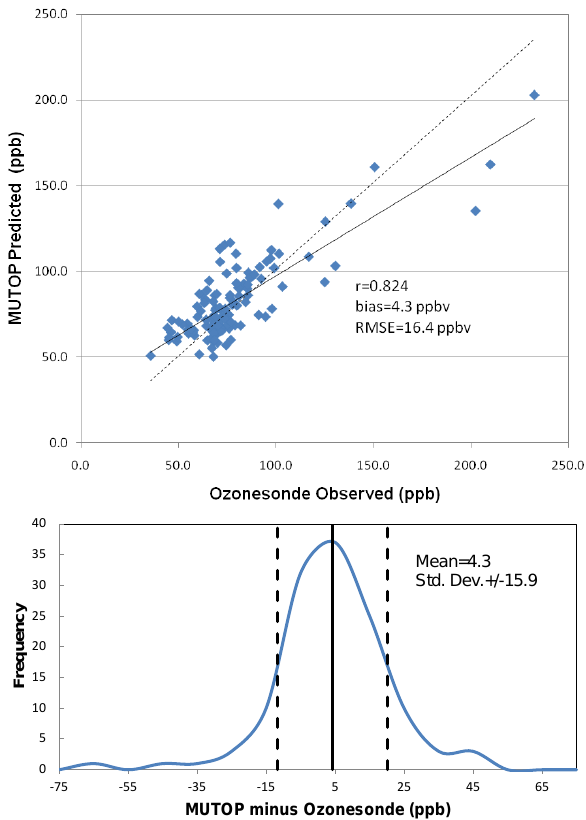
Fig. 4. (a) . Correlation between MUTOP-estimated layer-average UT ozone and ozonesonde-measured layer-average UT ozone, one- to-one line (dashed), best fit line (solid): r = 0 . 824; MUTOP ex- plains 68% of observed variability. b) Frequency distribution of error, defined as the predicted (MUTOP) minus the observed (ozonesonde) with the average denoted by the solid line and the standard deviation by the dashed lines; shows the overall tendency for the TES derived image product to over predict the observed ozone by about